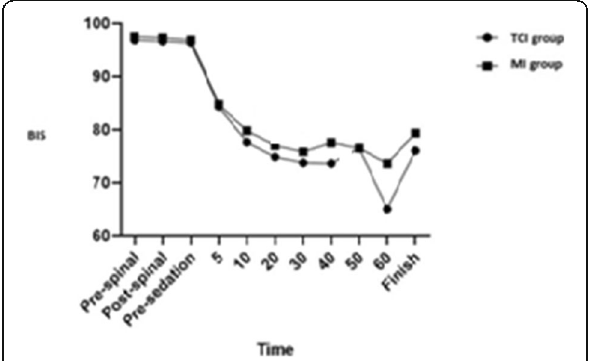
Fig. 3 Changes in heart rate. Values are mean ± SD